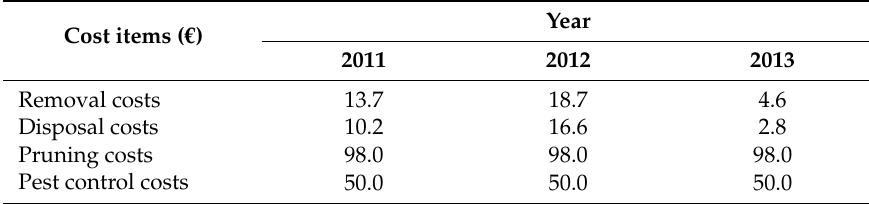
Table 2. Costs (in thousands of Euros) for the damaged and healthy Canary Palms (years 2011, 2012, 2013).